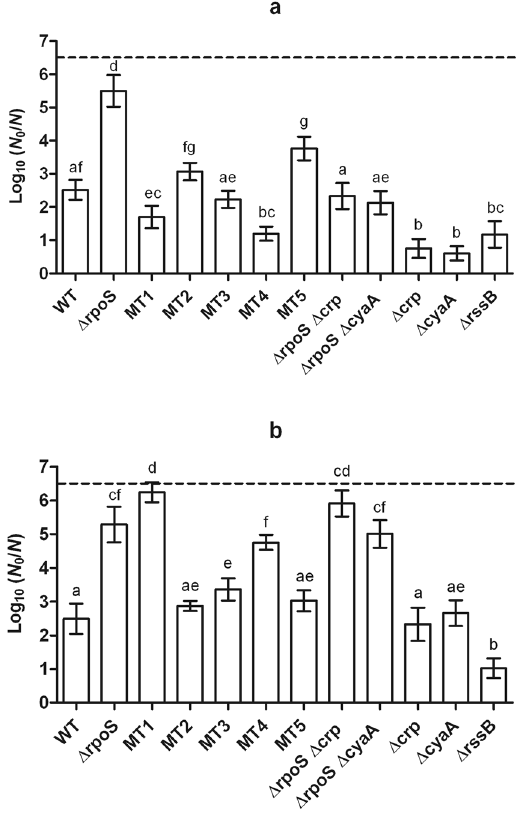
Figure 2. Logarithmic reduction factor of E. coli MG1655 WT and indicated mutants by a HHP treatment at 500 MPa ( a ) or heat treatment at 57.0 °C ( b ) for 15 min. The dotted line represents the quantification limit (1,000 CFU/ml). Letters indicate statistically significant differences ( P ≤ 0.05) among the inactivation of all